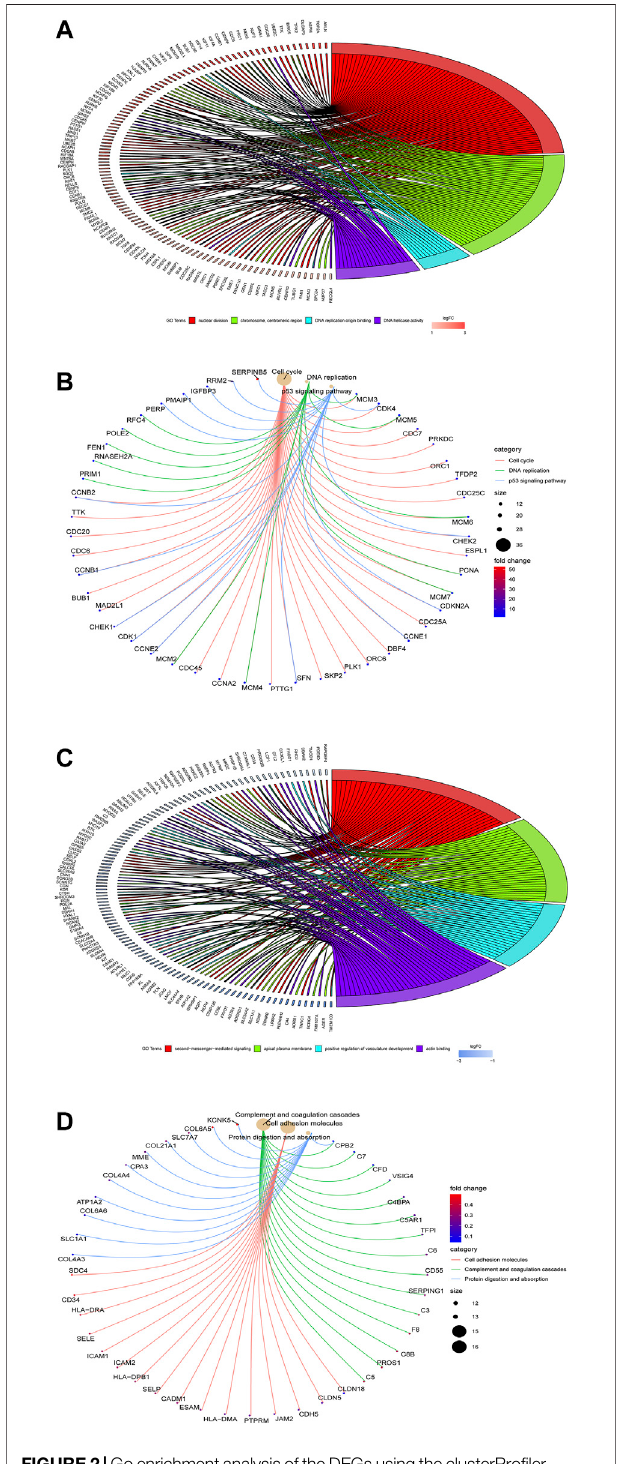
FIGURE2| GoenrichmentanalysisoftheDEGsusingtheclusterPro fi ler andGOplotpackages.GOenrichment (A) andKEGGpathway (B) analysesof upregulated DEGs are performed, while GO enrichment (C) and KEGG pathway (D) analyses of downregulated DEGs are performed.